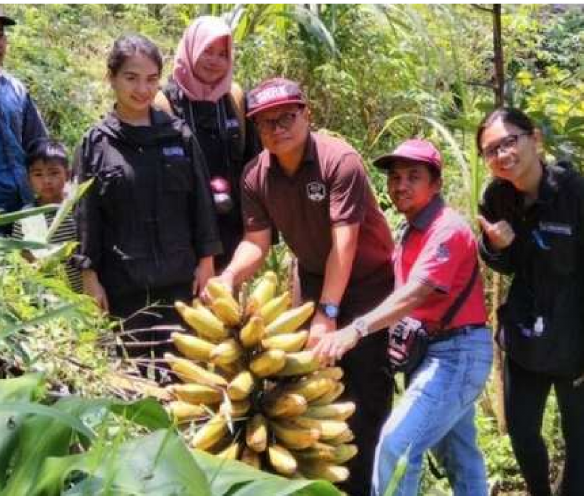
Figure 6. The observers (left to right: local people of Padakembang village, Carolin, Giashinta Stefani, Ketut Wikantika, Agus Sutanto, Intan Fatmawati) with the Musa troglodytarum fruits found in the Padakembang villages near the Galunggung mountains, Tasikmalaya